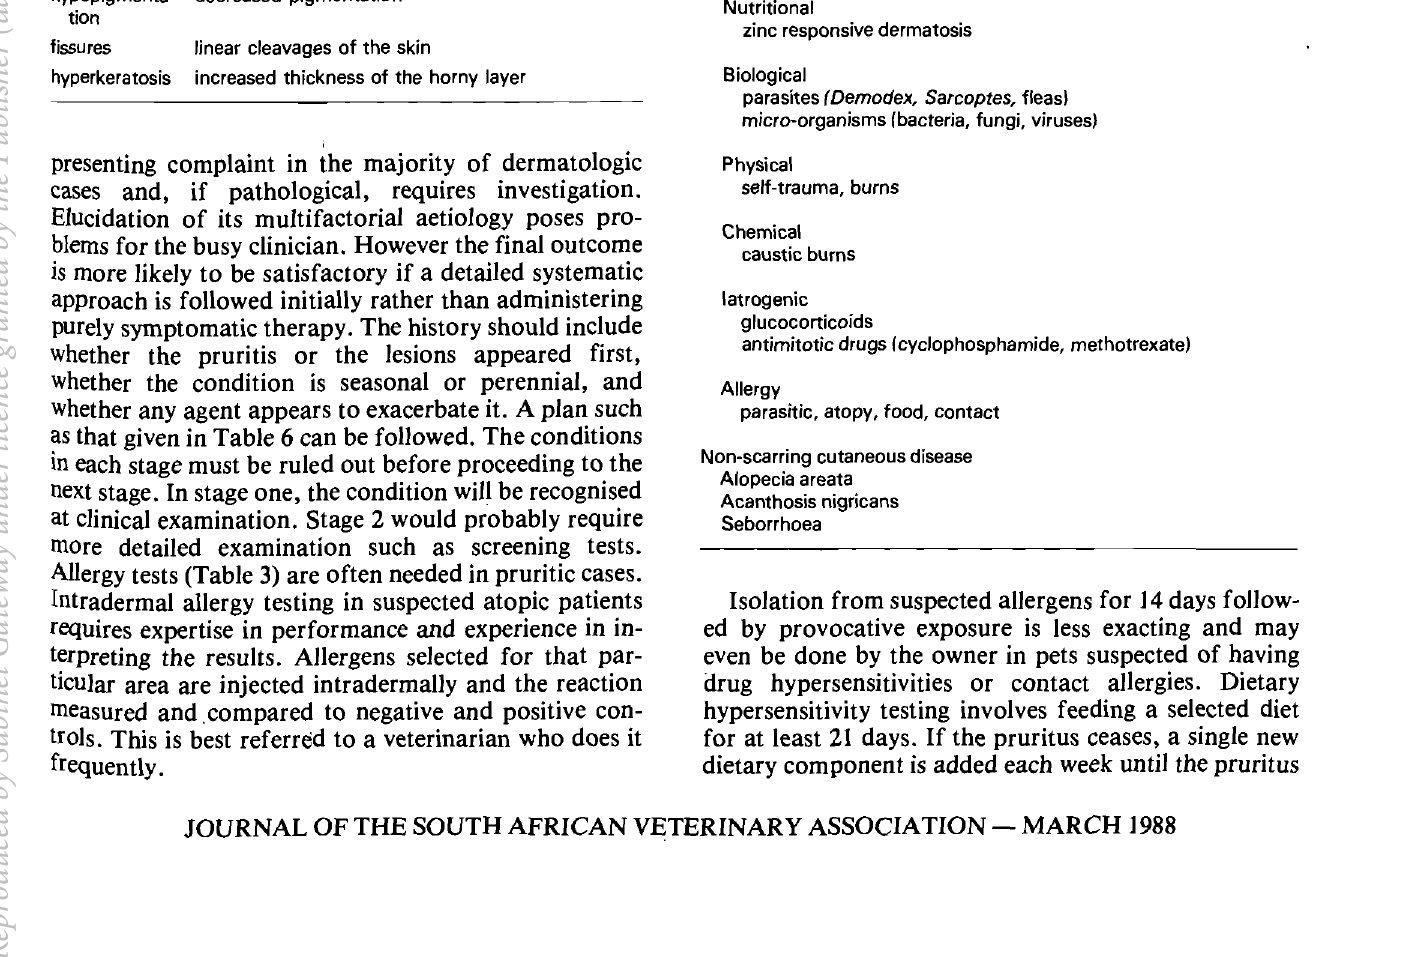
Table 7: Alopecia: contributing